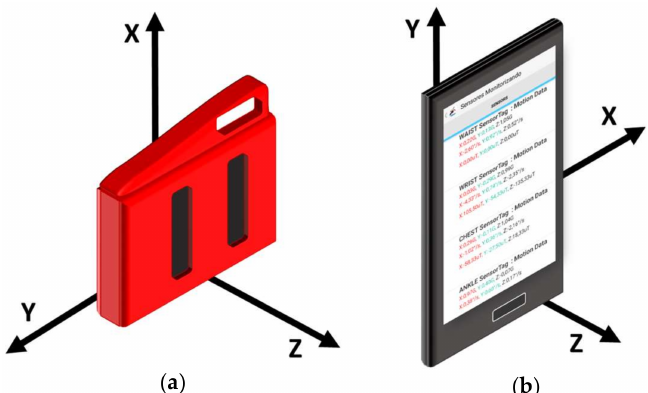
Figure 3. Representation of the spatial reference system of the employed sensing devices (devices are firmly attached to the subjects’ body to guarantee that the reference system does not change during the experiments). ( a ) SensorTag ( b ) Smartphone.